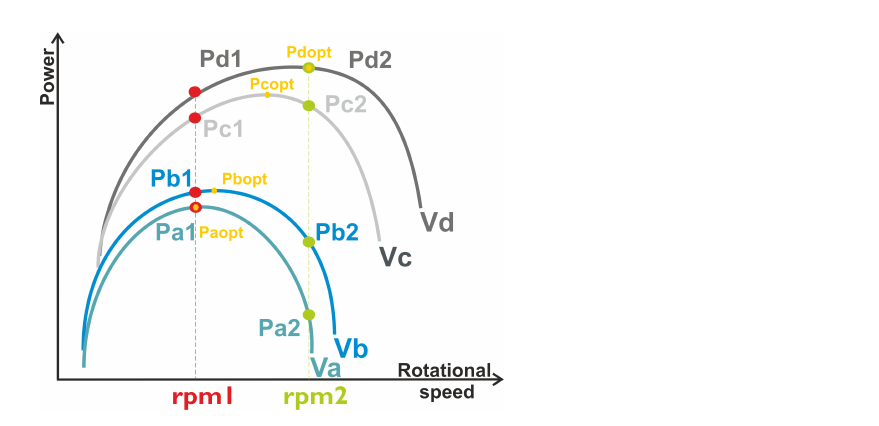
Figure 10. Power versus rotational speed of dual-speed wind turbine generation. Table 2. Example of multi-megawatt constant speed operational wind